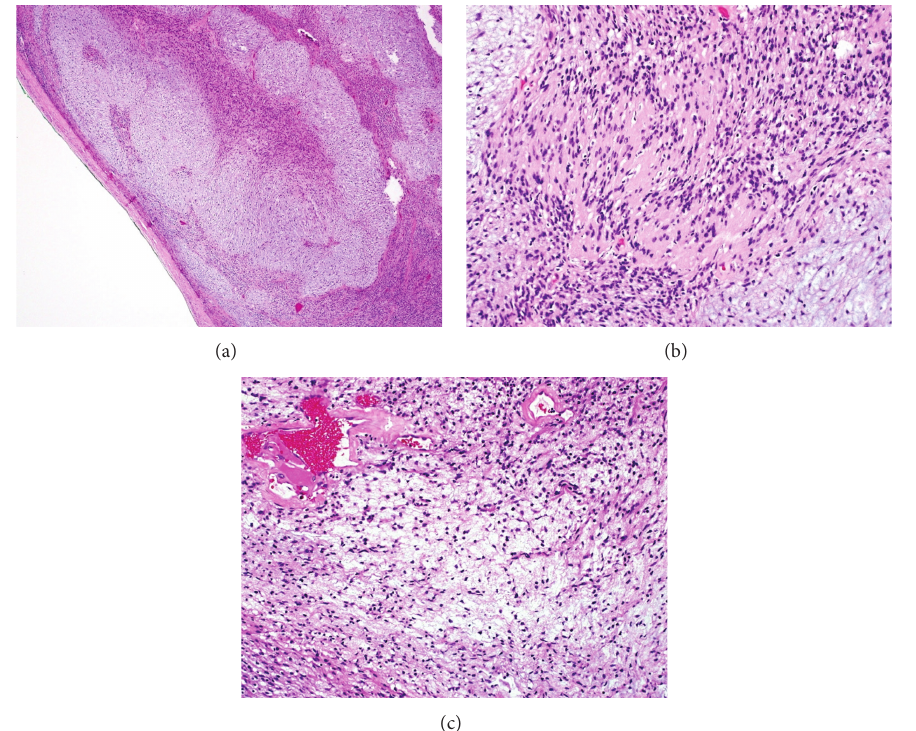
Figure 2: Microscopic examination of pleural mass (hematoxylin and eosin [H&E] stain). (a) Encapsulated mass with marked myxoid changes. (b) Monomorphic spindled Schwann cells forming cellular Antoni A areas with nuclear palisading and Verocay bodies alternating with hypocellular myxoid area. (c) Schwann cells with inconspicuous cytoplasm and nuclei suspended in myxoid matrix and areas of typical perivascular hyalinization.